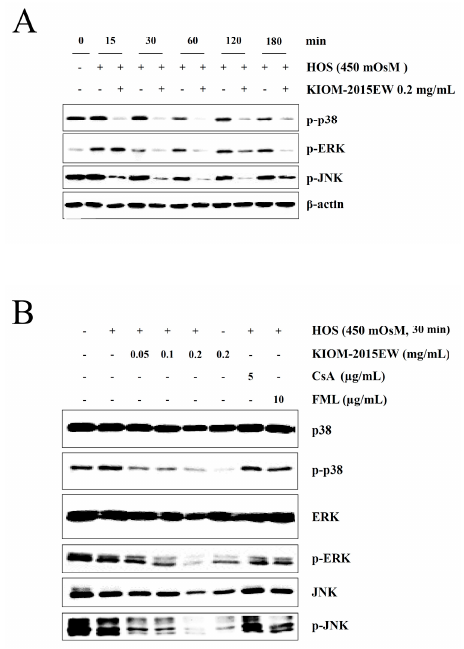
Figure 4. Regulation of Mitogen-activated protein kinase (MAPK) activation by KIOM-2015EW in HOS-induced MAPK phosphorylation. ( A ) HCECs were exposed to HOS for 15, 30, 60, 120, and 180 min, and the expression levels of MAPK proteins, including p38, extracellular signal regulated kinase (ERK) and c-Jun N-terminal kinase (JNK), phospho-p38 (pp38), phospho-ERK (pERK), and phospho-JNK (pJNK), were determined by western blot analysis; ( B ) HOS-exposed HCECs were treated with KIOM-2015EW for 30 min, and the expression levels of pp38, pERK, and pJNK were verified by western blot analysis. CsA and FML were used as positive anti-inflammatory drugs. β -Actin was used as the loading control. Data are presented as the mean ± SD of three independent experiments. The full size blot is shown in Supplementary Figure S3.